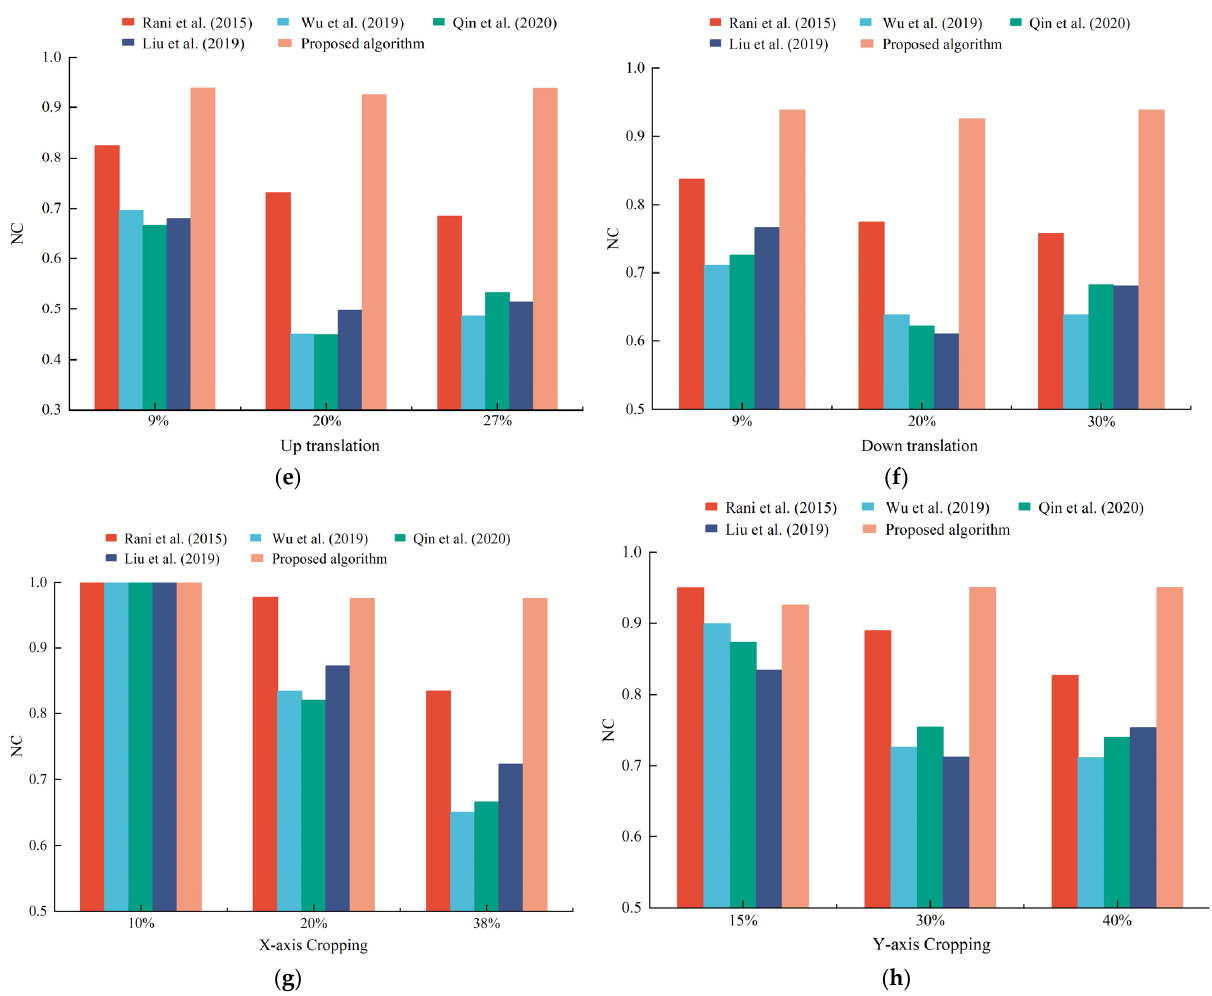
Figure 17. Comparison of the robustness of different algorithms under geometric attacks: ( a ) rotation; ( b ) scaling; ( c ) left translation; ( d ) right translation; ( e ) up translation; ( f ) down translation; ( g ) X-axis cropping; and ( h ) Y-axis cropping.